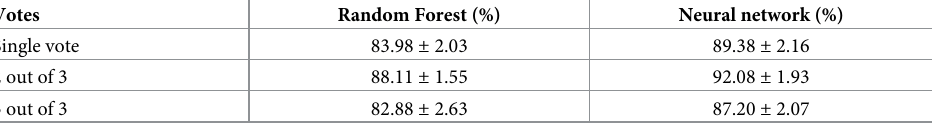
Table 2. Accuracy of a voting classifier for predicting chromosomal and plasmid sequences using 5kb sequence fragments from each contig and voting based on the majority � .